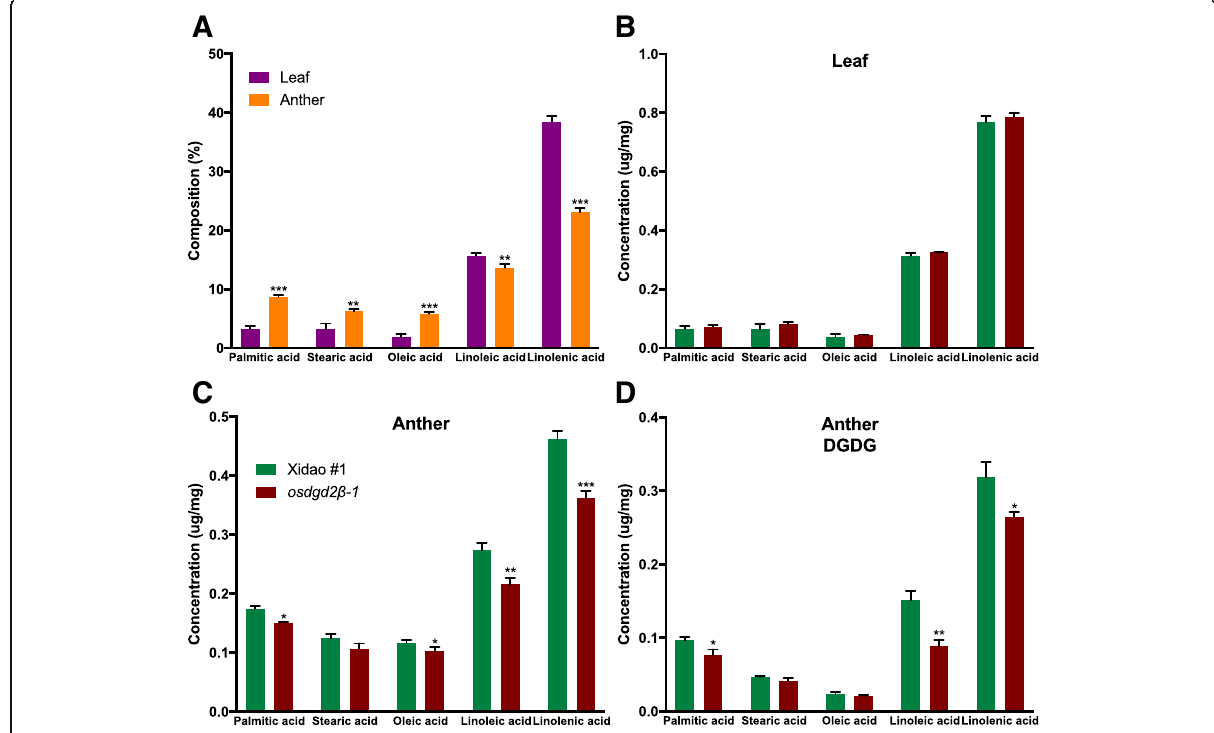
Fig. 4 Fatty acid composition in leaf and anther of wild-type cultivar Xidao #1 and its mutant osdgd2 β -1 . a shows the fatty acid composition in leaf (purple) and anther (orange) in weight percentage of wild-type. b & c show concentration of fatty acids in leaf and anther, respectively. d shows concentration of fatty acids in DGDG spot obtained from TLC (refer Additional file 4: Figure S3) . All values represent means ± standard deviations. Asterisk represent statistically significant differences (Tukey ’ s test, * P < 0.05, ** P < 0.01, *** P < 0.001). Fatty acid concentration in b , c and d are measured on the basis of fresh weight of tissue